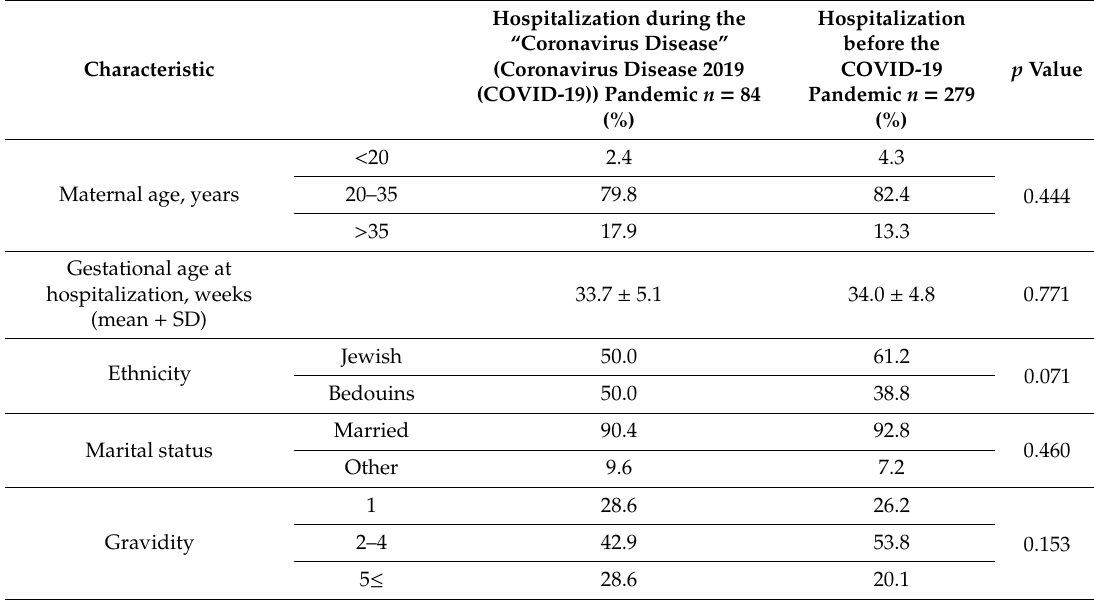
Table 1. Demographic and obstetric characteristics of the study